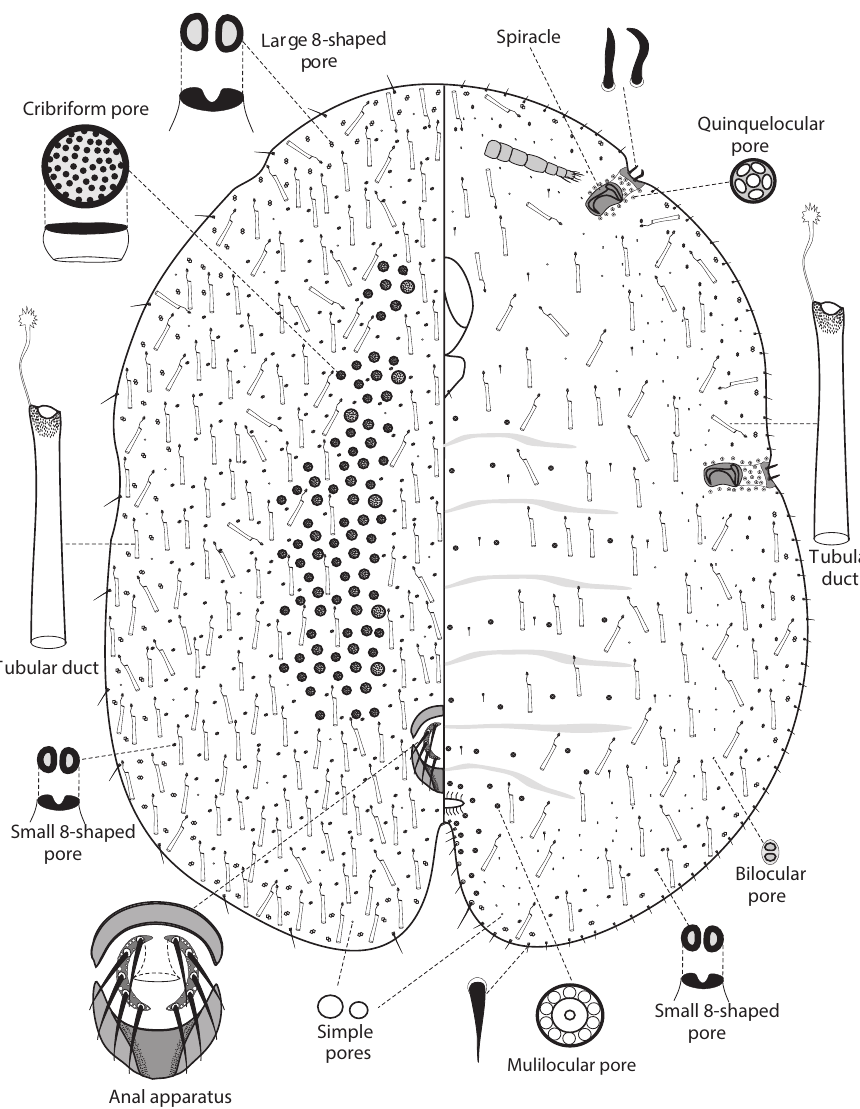
Figure 1. Morphology of Psoraleococcus multipori , adult female, Indonesia (Sulawesi). chromatinization are always the males and so, bisexual reproduction may be presumed in Psoraleococcus multipori . On the other hand, the adult males or male larvae have not been collected up to now in any species of the genus Psoraleococcus Borchsenius, 1960. This situation is probably connected with separate lives of female and male colonies on different parts of a host plant or even on different plants. Moreover, all species of Psoraleococcus live in symbiosis with ants (Lambdin and Kosztarab 1973) which may transport different instars of scale insects inside hidden underground galleries, which significantly impedes their detection and